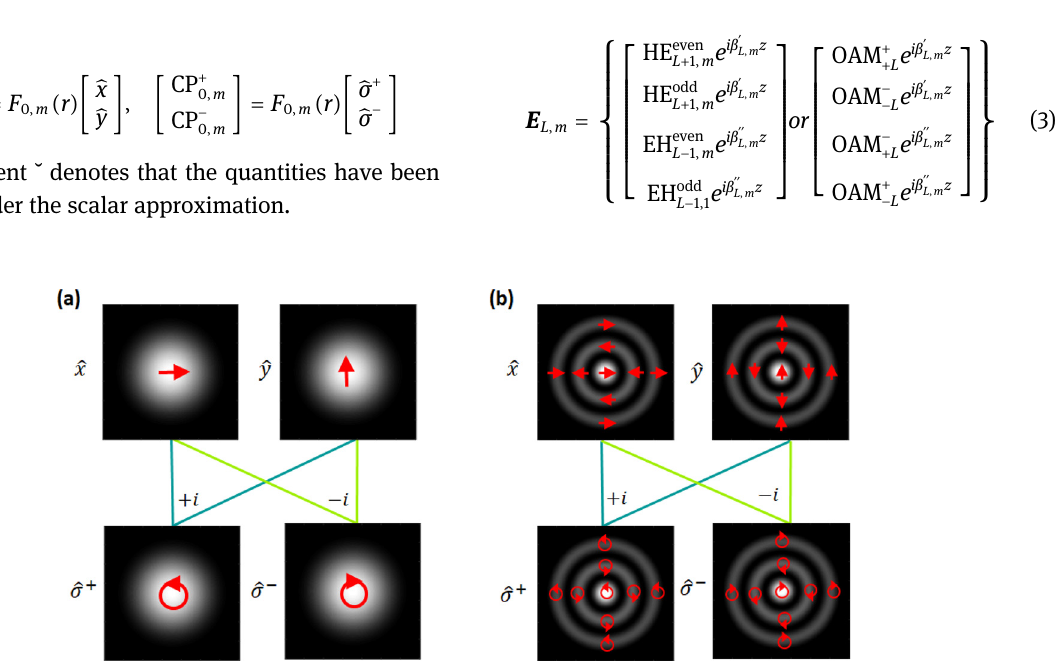
Figure 1: Field representations for L = 0 modes in a circular, step-index-guided fi ber. Gray scale images show intensity distributions and red arrows indicate polarization state, either linear (straight arrows in top row) or circular (circular arrows in bottom row). The relationship between linear and circular polarizations are shown for the (a) m = 1 and (b) m = 3 modes. The colored lines indicate that the circular polarization modes can be represented as linear combinations of the two orthgonal linear polarization modes. The + i or − i terms represent a π /2 or − π /2 phase shift in the linear combinations. Conversely, linear polarization modes can be decomposed into two orthogonal circular polarizationmodesaswell.Thepositionwherethearrowheadsisshownwithinthecirclesrepresentingcircularpolarizationsareintentionally distinct, indicating a phase shift. Circular polarization representations where the arrowhead is on the top portion of respective circles is π phase-shifted from those in which they are on the bottom of the circle. This is a common feature of LP 0, m or CP 0, m modes – that each adjacent intensity ring of the mode accumulates a π phase shift and hence their fi elds are fl